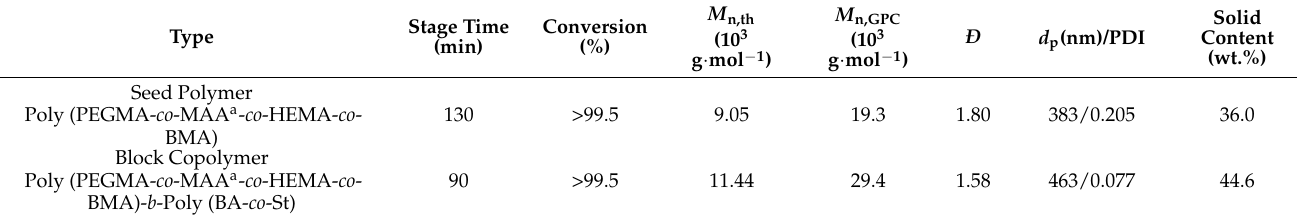
Table 12. Chain extension reaction with BA and St.